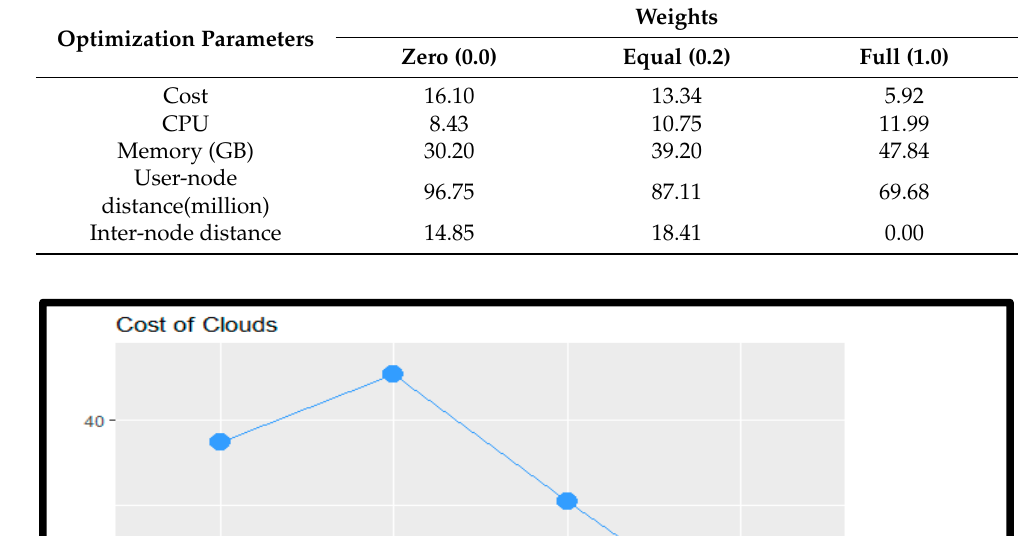
Table 7. ANOVA Table for Memory on clouds for different virtual machines .